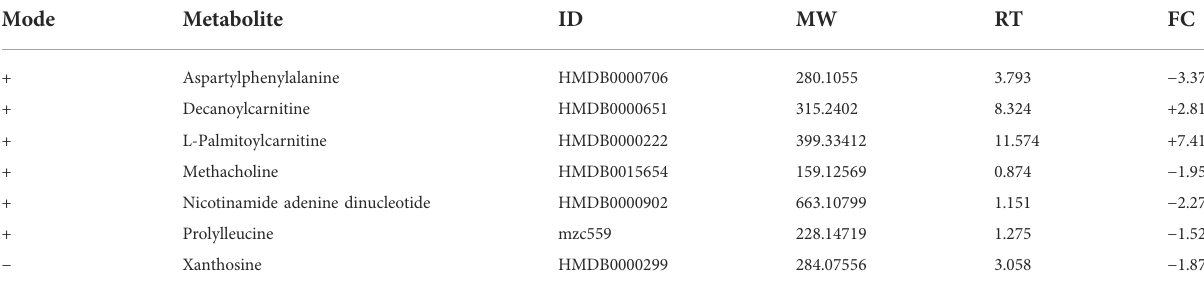
TABLE 4 List of metabolites in YT against